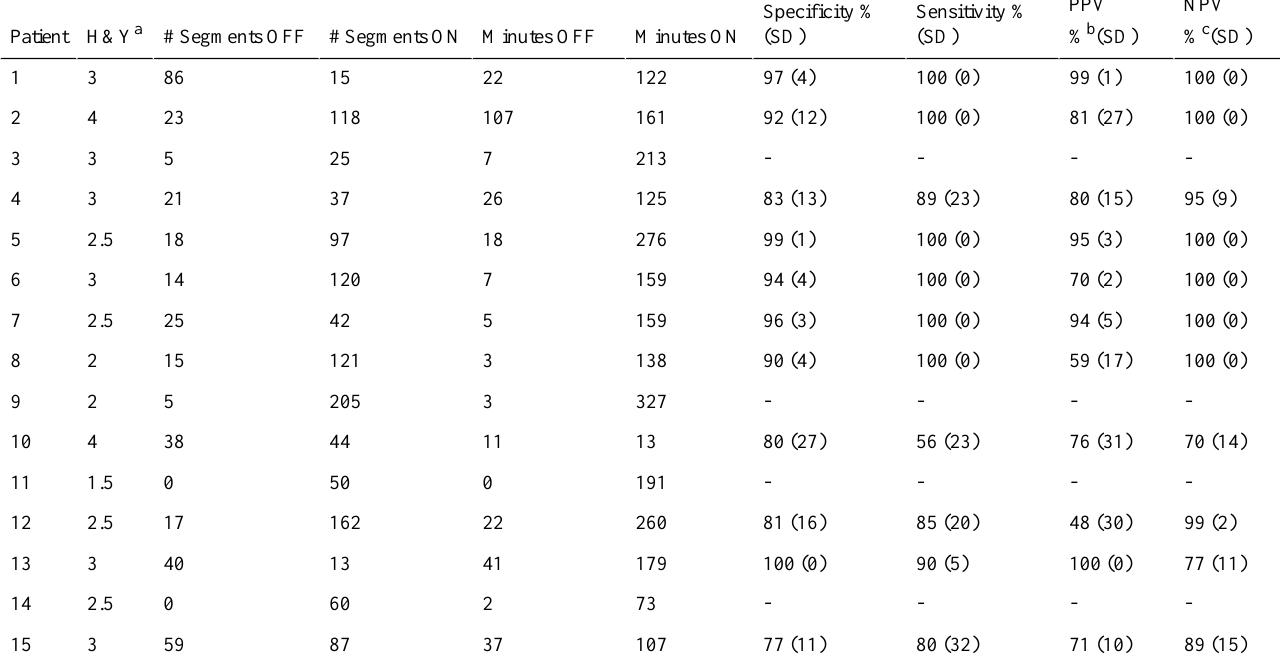
Table 1. Algorithm applied to walking segments of any